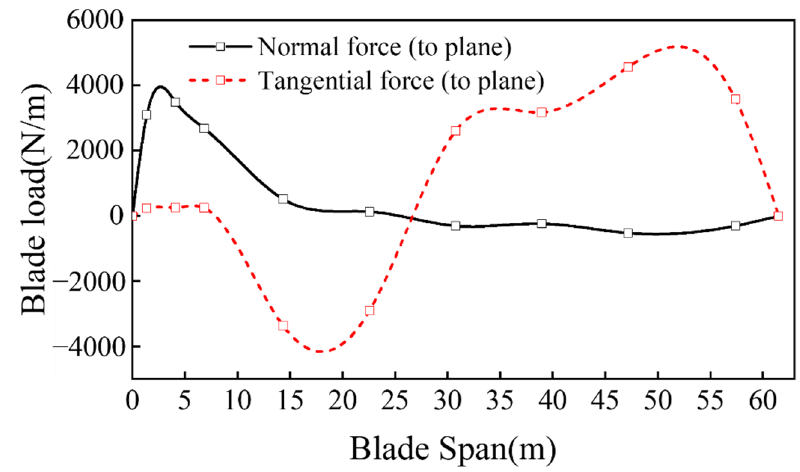
Figure 4. Aerodynamic loads computed in OpenFast.